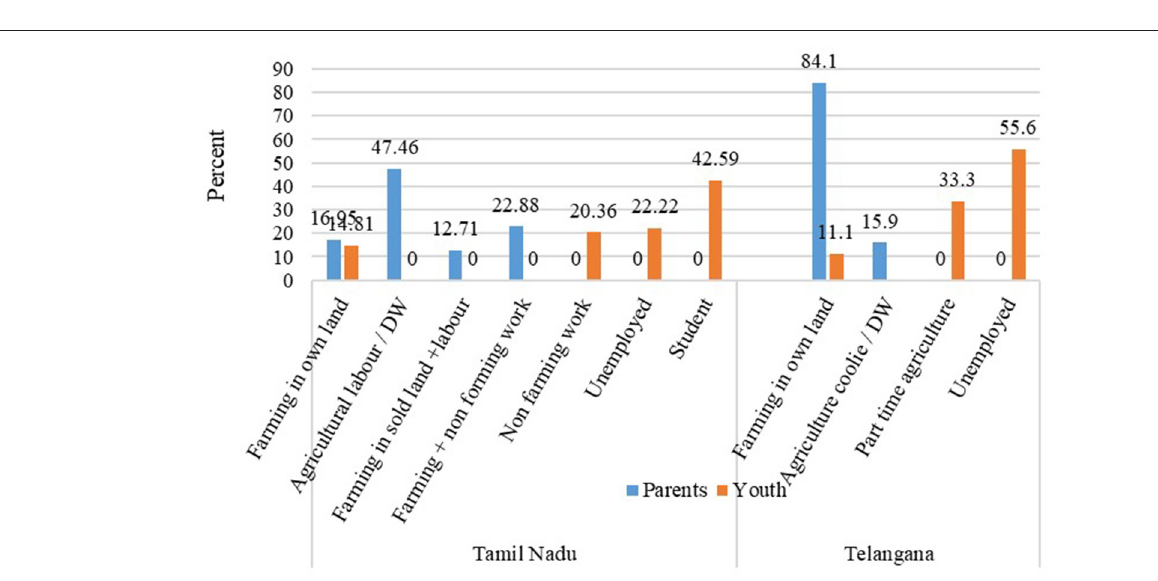
FIGURE 7 | Occupational status of farm parents and